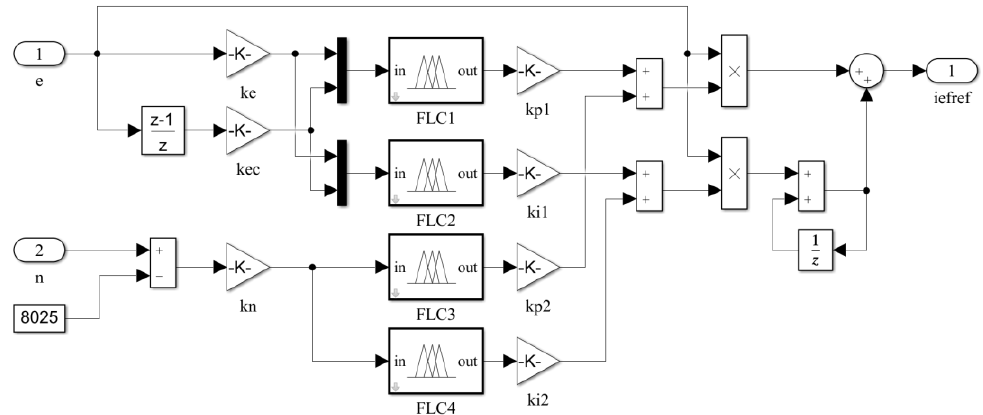
Figure 13. Simulink model of the dual fuzzy PI controller.